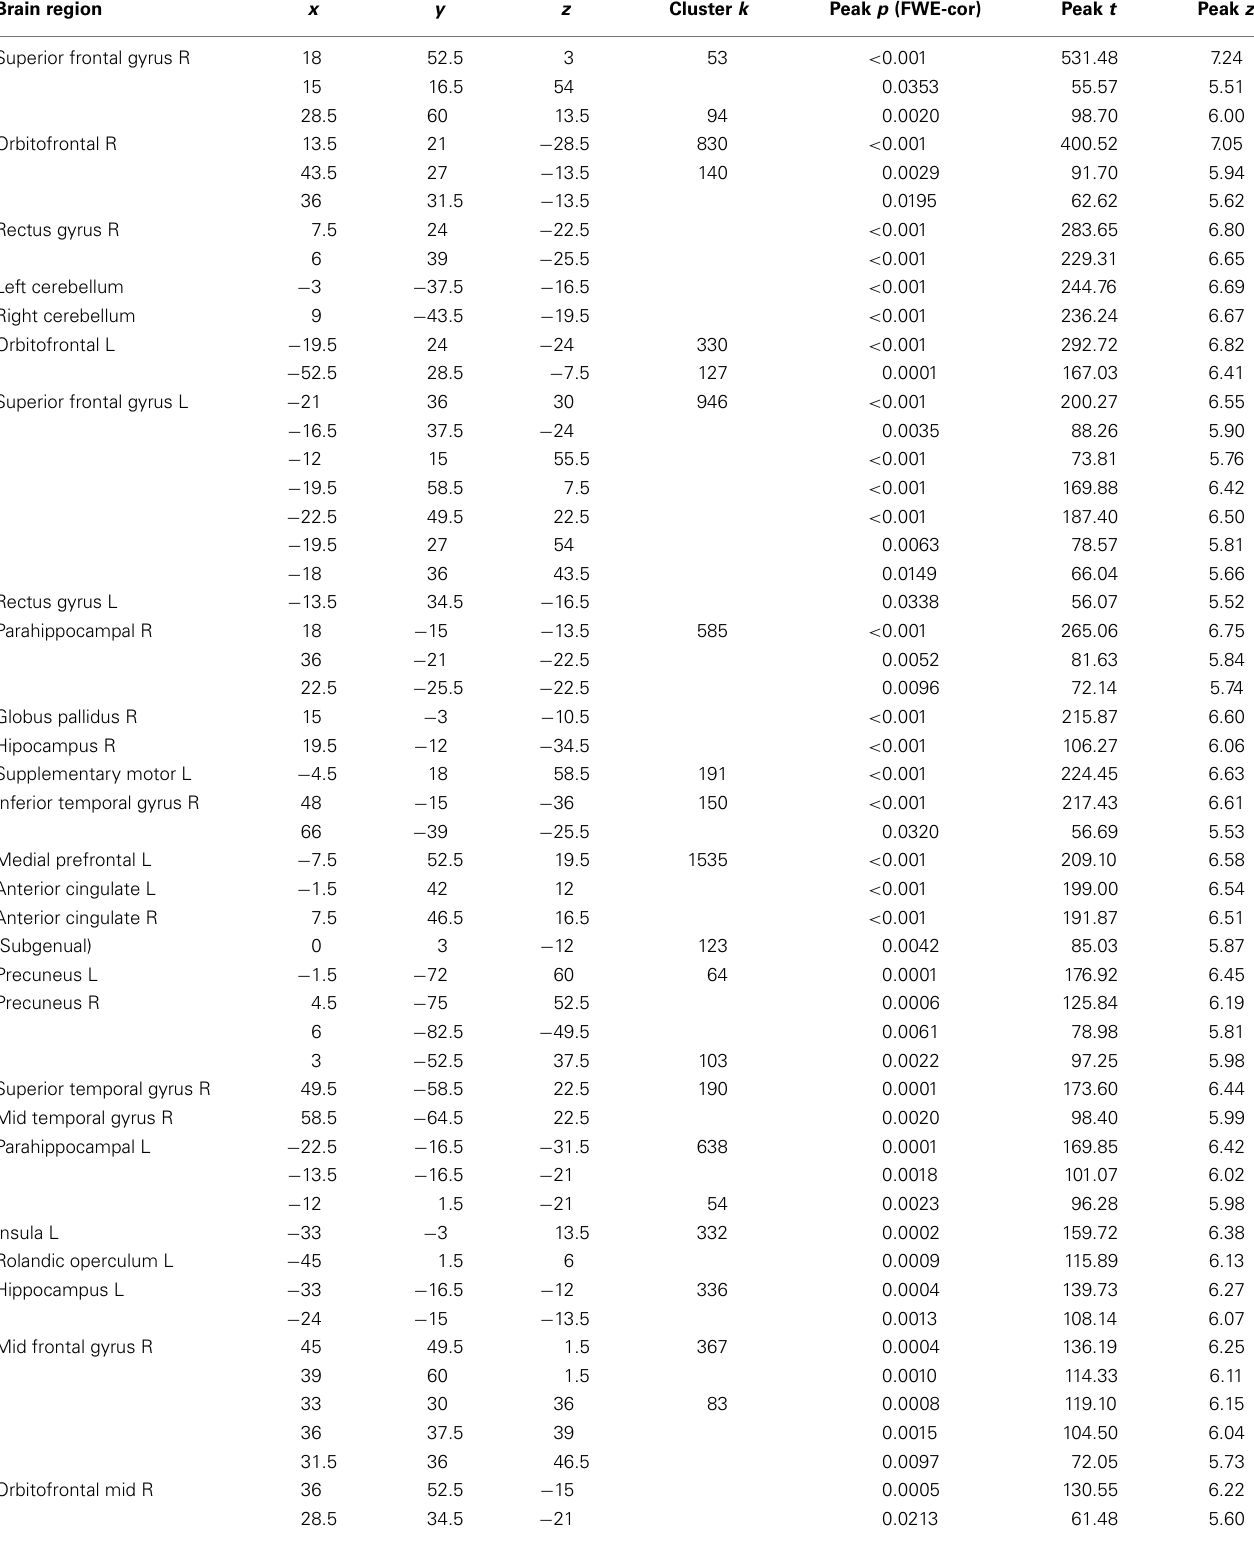
Table 3 | Brain sites of CS patient significant atrophy